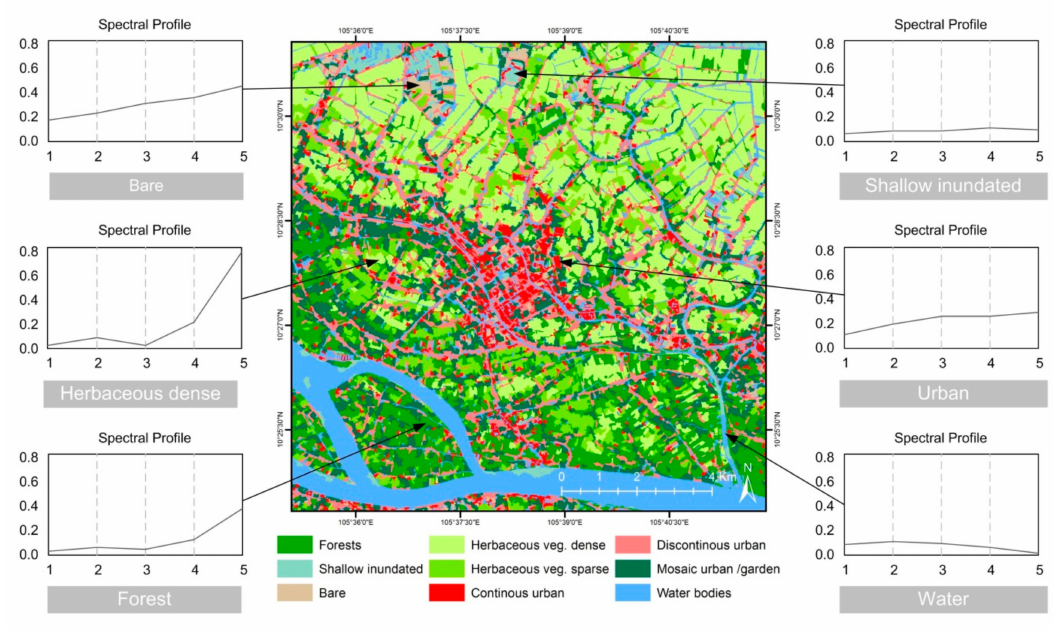
Figure 12. The spectral reflectance “fingerprint” of surfaces. Excerpt of Mekong Delta land use classification based on 6.25 m resolution Rapid Eye data. Spectral profiles depict spectral reflectance in % ( y -axis) for the five Rapid Eye spectral bands (1: 440–510 nm (blue), 2: 520–590 nm (green), 3: 630–685 nm (red),4: 690–730 nm (red edge), 5: 760–850 nm (near